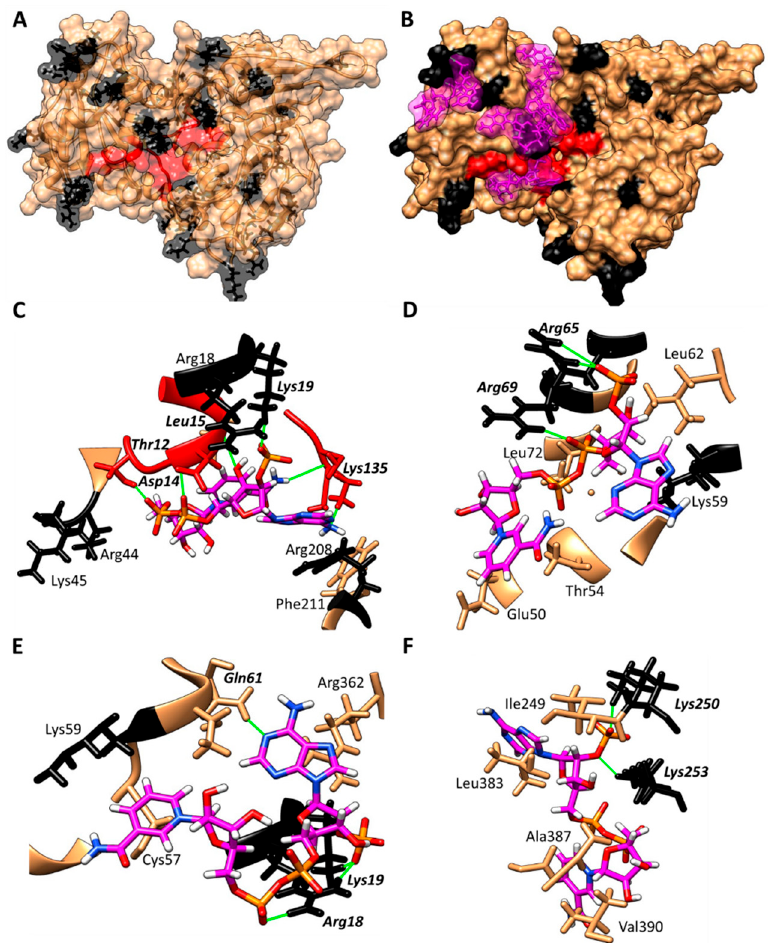
Figure 7. Docking study between HpG6PD and the NADP + molecule. ( A ) Model of the HpG6PD enzyme, showing the Lys and Arg residues in black at the points where trypsin can hydrolyze. ( B ) Results of the docking study, showing four zones of possible interaction of the NADP + molecule with HpG6PD; the NADP + molecule is shown in a magenta color. ( C – F ) Zoomed-in view of the predicted interaction zones between the HpG6PD enzyme and the NADP + molecule; hydrogen bridges are shown in green, while the amino acids involved are shown in bold